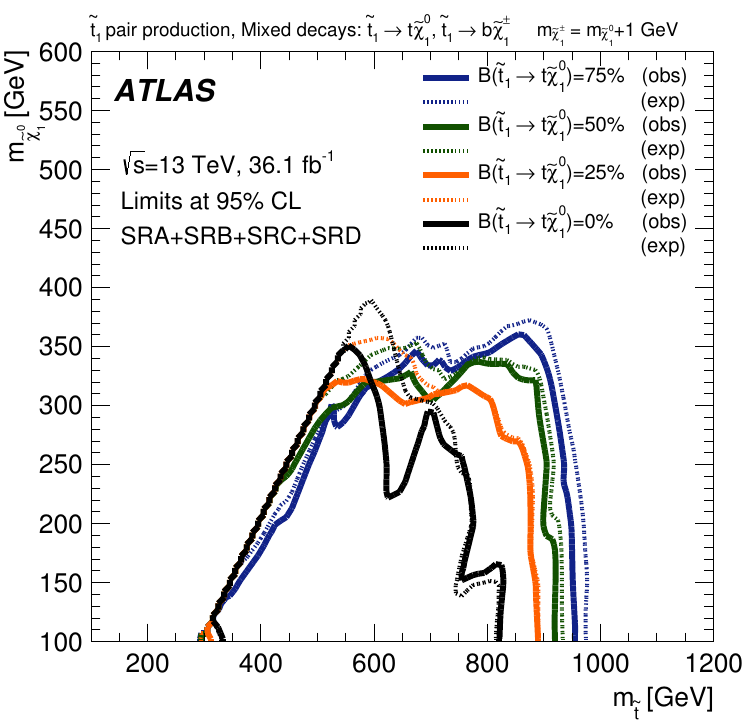
Figure 9. Observed (solid line) and expected (dashed line) exclusion contours at 95% CL as a function of ~ t 1 and ~ (cid:31) 0 1 masses and branching ratio to ~ t 1 ! t ~ (cid:31) 0 1 in the natural SUSY-inspired